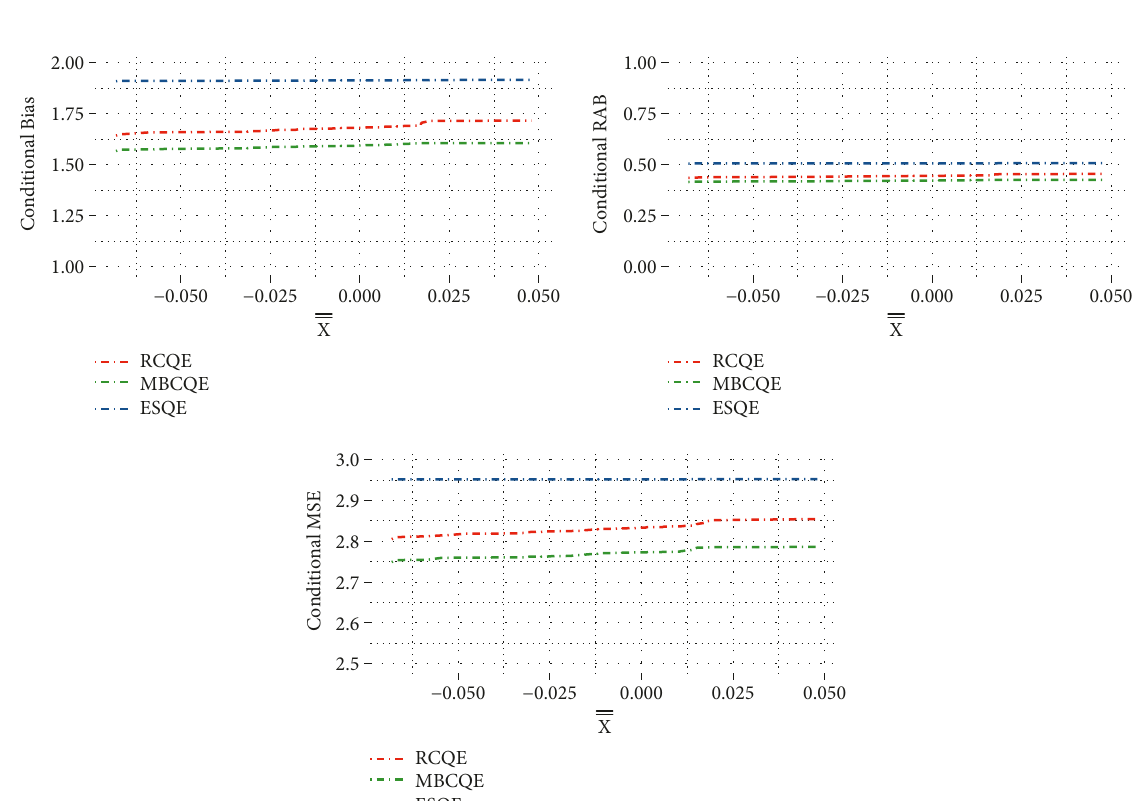
Figure 1: CB, CRAB, and CMSE for estimators: linear mean function, α � 0 .